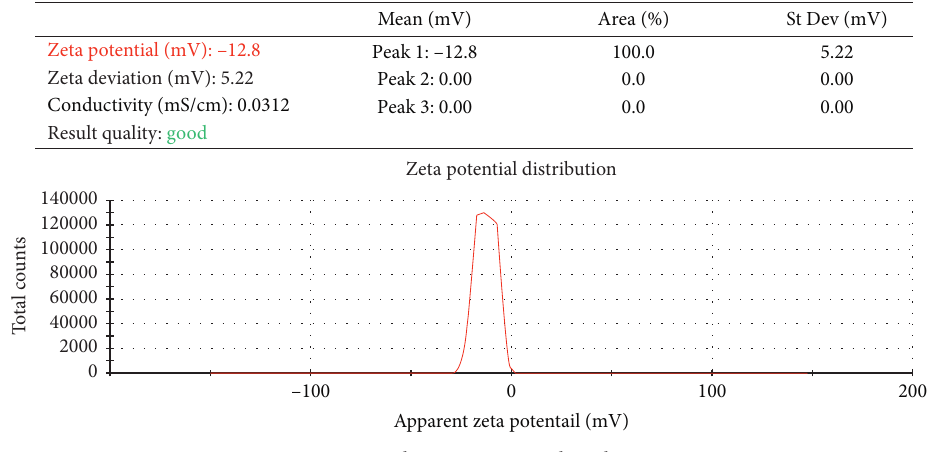
Figure 4: Silica zeta potential analysis.